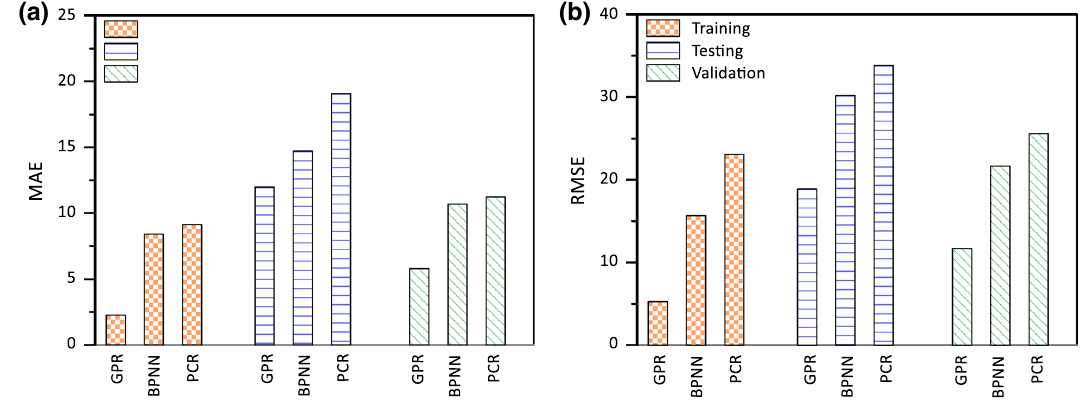
Fig. 9 Performance of models at training, testing and validation stage: a MAE; and b RMSE